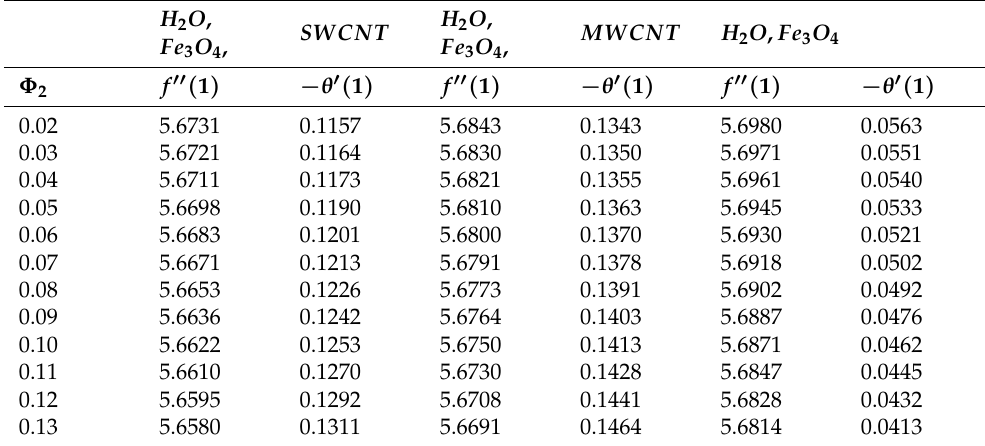
Table 7. Numerical results by BVP4C Method for hybrid nanofluid with various physical